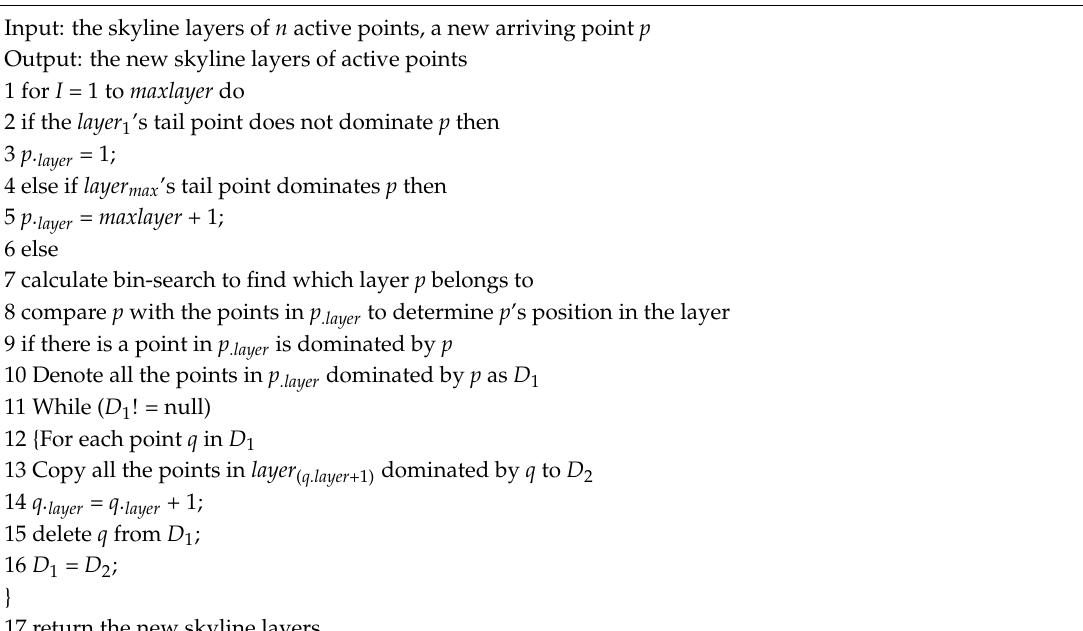
Figure 5. New skyline layers. Algorithm 1. Update Skyline Layers When New Point Arrives